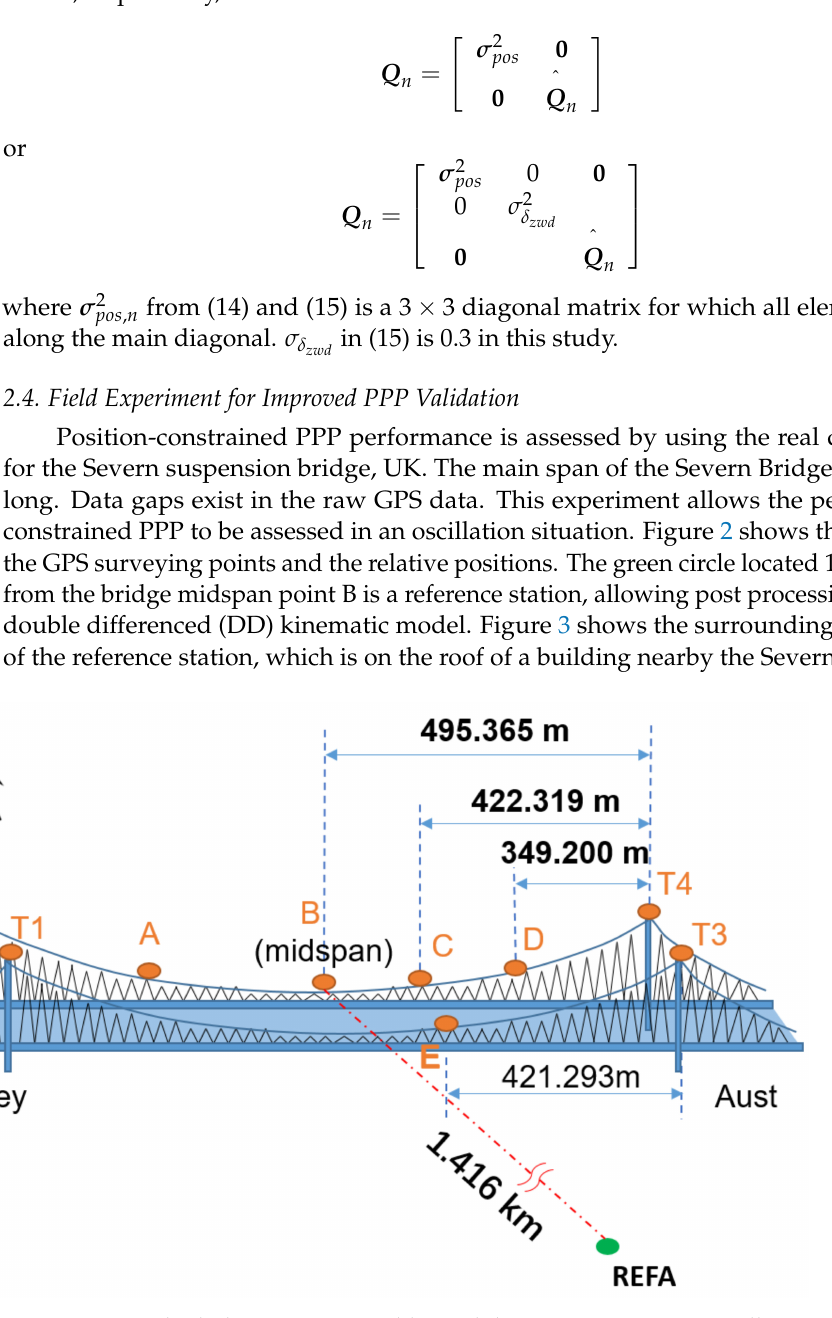
Figure 2. Locations of surveying points on both the suspension cables and the support towers, as well as one reference station, based on the Aust and east